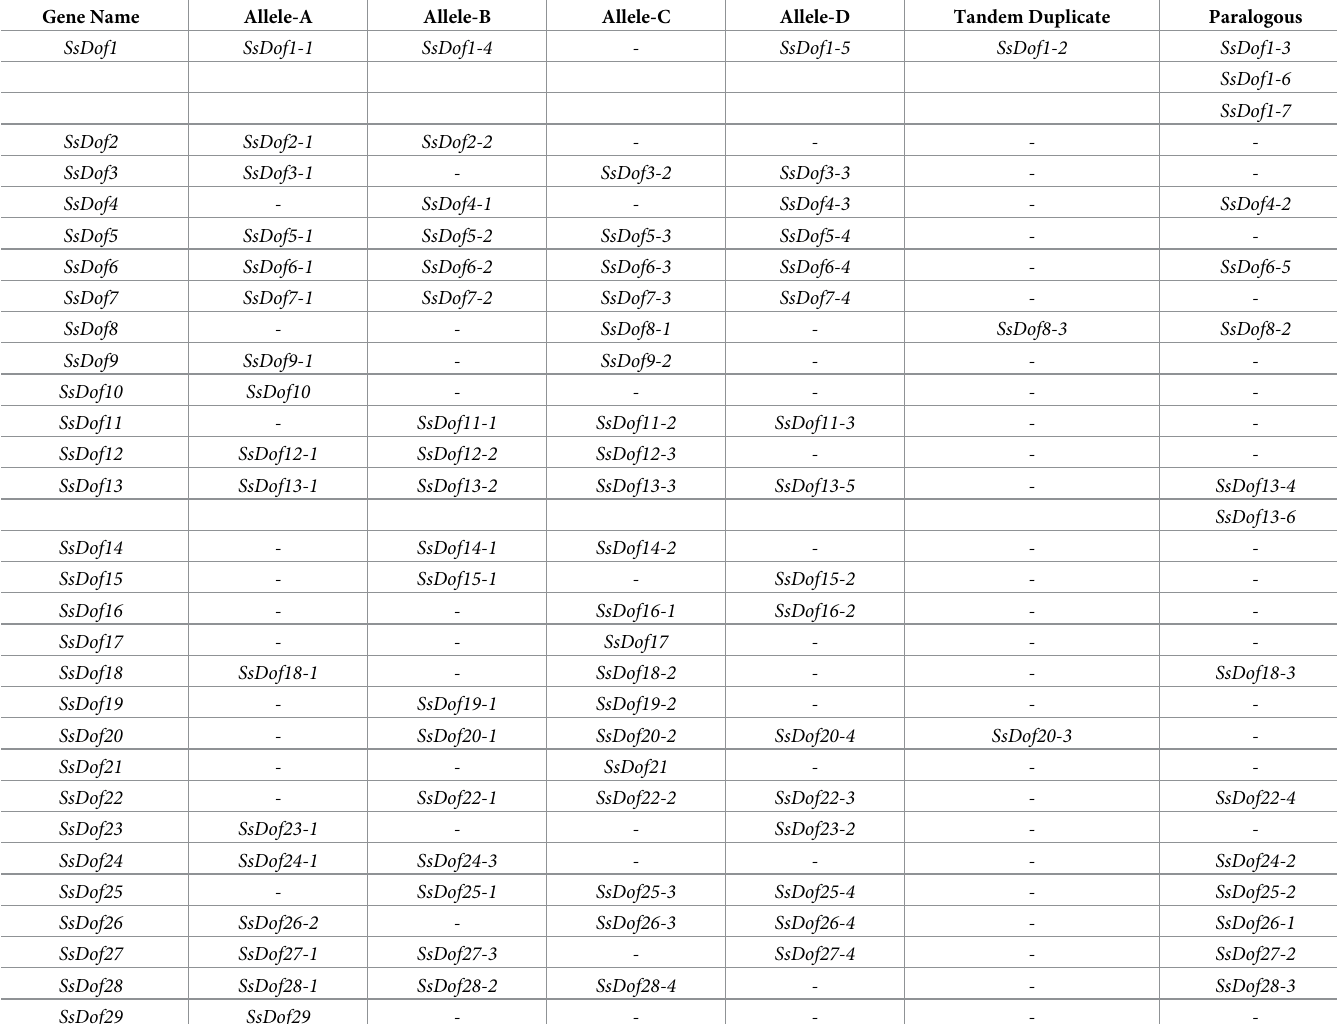
Table 1. Identification of the alleles and duplicates of SsDof genes in